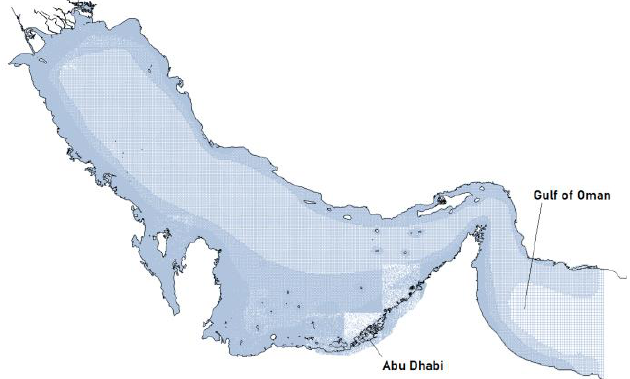
Figure 2. DELFT3D AGM Gulf model unstructured grid.